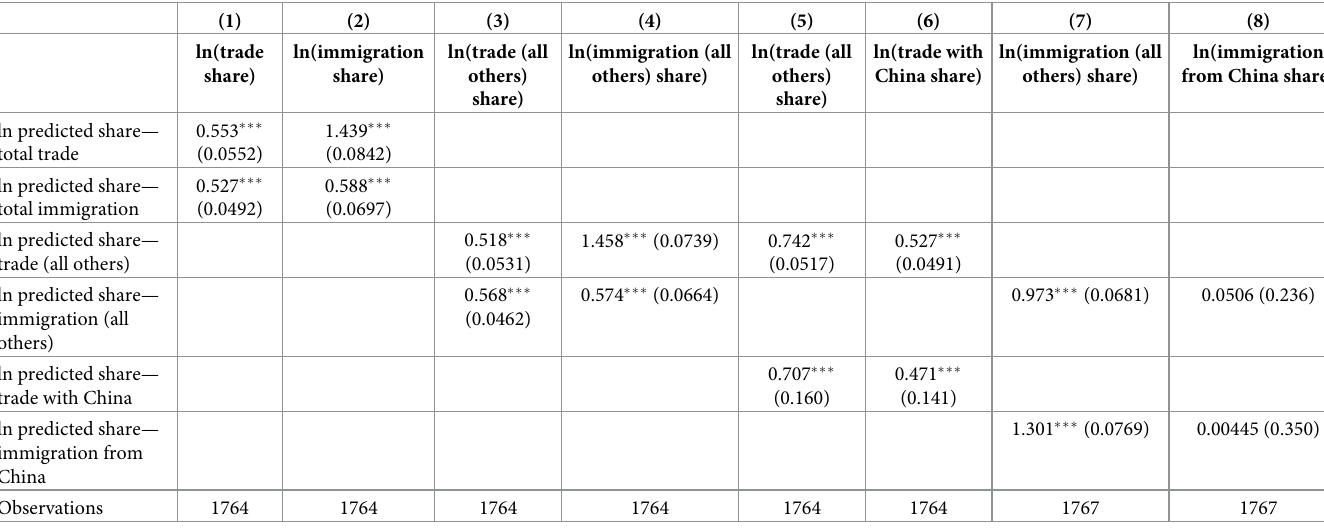
Table 11. Discrimination, openness to trade and immigration (alternative trade and migration data): 1st-stage result.